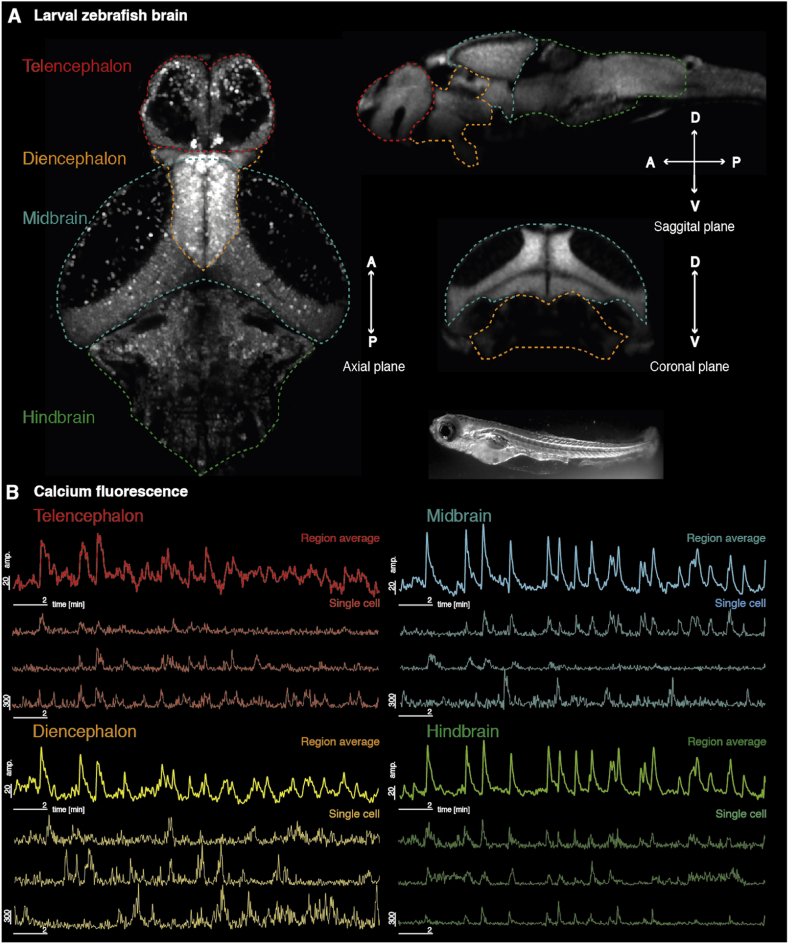
Calcium imaging of larval zebrafish. (A) A single axial plane from live two-photon imaging of a larval zebrafish brain is shown at 7 days post fertilisation on the left. On the right, sagittal and coronal views of a reference image [http://www.zbbrowser.com] [90] are shown to illustrate the 3D location of different brain areas. A zebrafish larva (not to scale) is shown at the bottom of the panel. (B) Example time series data are shown for regional averages of gross anatomical brain regions, as well as example cells identified in each area.